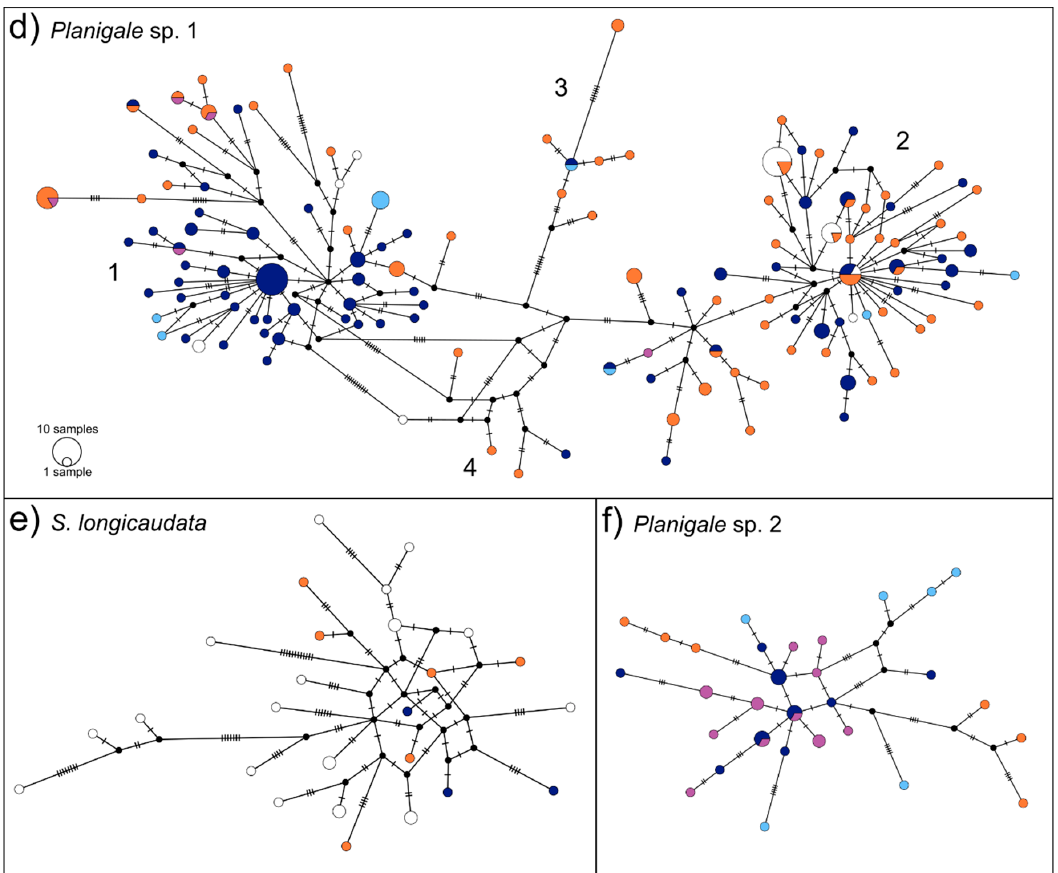
Figure 3. Concatenated mtDNA networks and map of samples for ( a ) S. ooldea ( n = 70), ( b ) S. youngsoni ( n = 113), ( c ) S. macroura ( n = 177), ( d ) Planigale sp. 1 ( n = 206), ( e ) S. longicaudata ( n = 30), and ( f ) Planigale sp. 2 ( n = 39). Circle size indicates the number of individuals sharing that haplotype, with larger circles indicating more common haplotypes, small black circles indicating nodes, and hatch marks showing missing haplotypes. Haplotypes are colored by the four IBRA regions and white for ‘non-Pilbara’ samples (see map top right). The major haplo groups are numbered. Concatenated mtDNA networks and map of samples for.